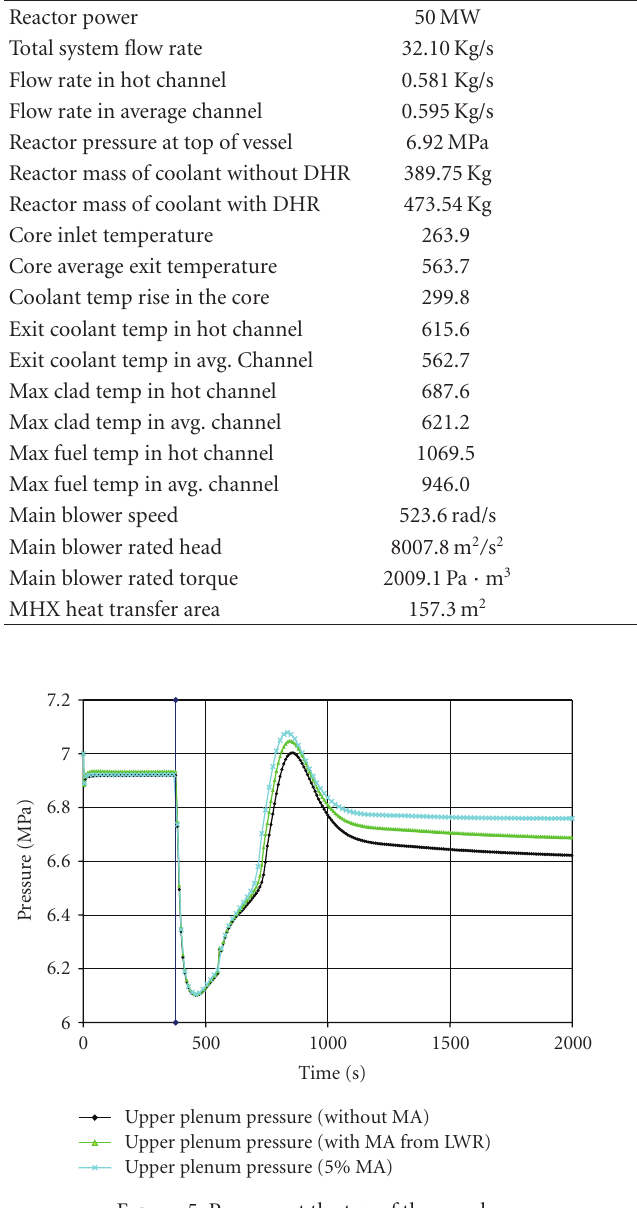
In the next figures, the LOFA transient evolution is shown. After the scram event, pressure and temperatures in the primary system start to drop, due to the stopped power generation in fuel. Before the closure of main circuit valves and opening of DHR valves, we can notice ( ∼ 100 seconds after scram) pressures and temperatures to start rising again, because of mass flow becoming too low. After 173 seconds after scram, blower relative rotational velocity falls below 10%, allowing the main valves to close and the DHR circuit to be opened, thus starting the insetting of Natural Circulation